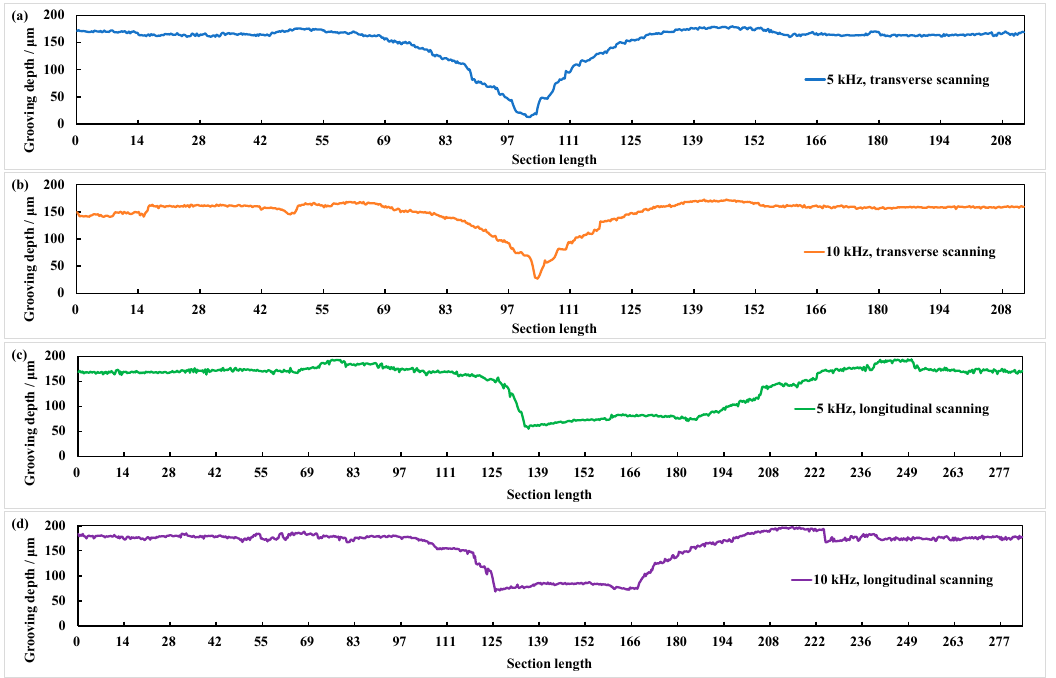
Figure 8. The section morphologies of grooves in different scanning directions. ( a ) Transverse scan- ning and repetition frequency of 5 kHz; ( b ) transverse scanning and repetition frequency of 10 kHz; ( c ) longitudinal scanning and repetition frequency of 5 kHz; ( d ) longitudinal scanning and repeti- tion frequency of 10 kHz.